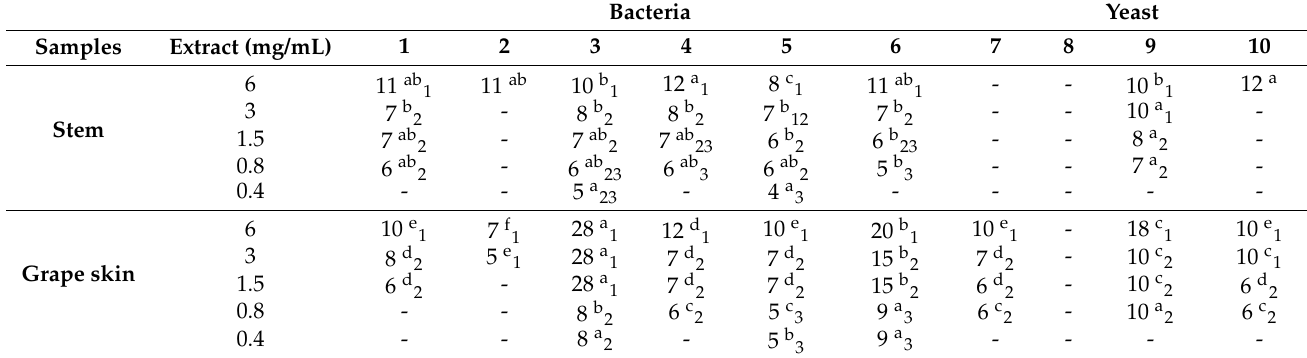
Table 2. Diameter of the zones of inhibition in millimeters of stem and grape-skin extract with different concentrations tested against bacteria and yeast.